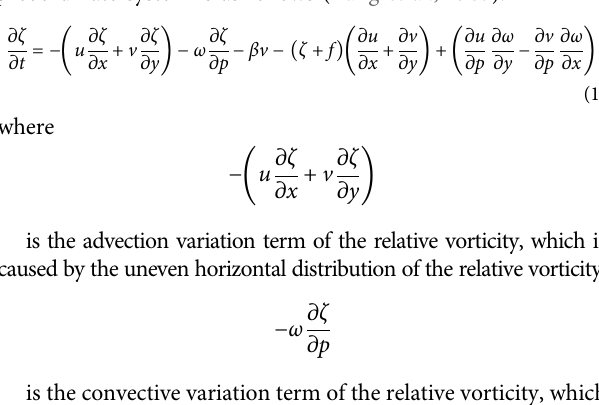
Frontiers in Earth Science |